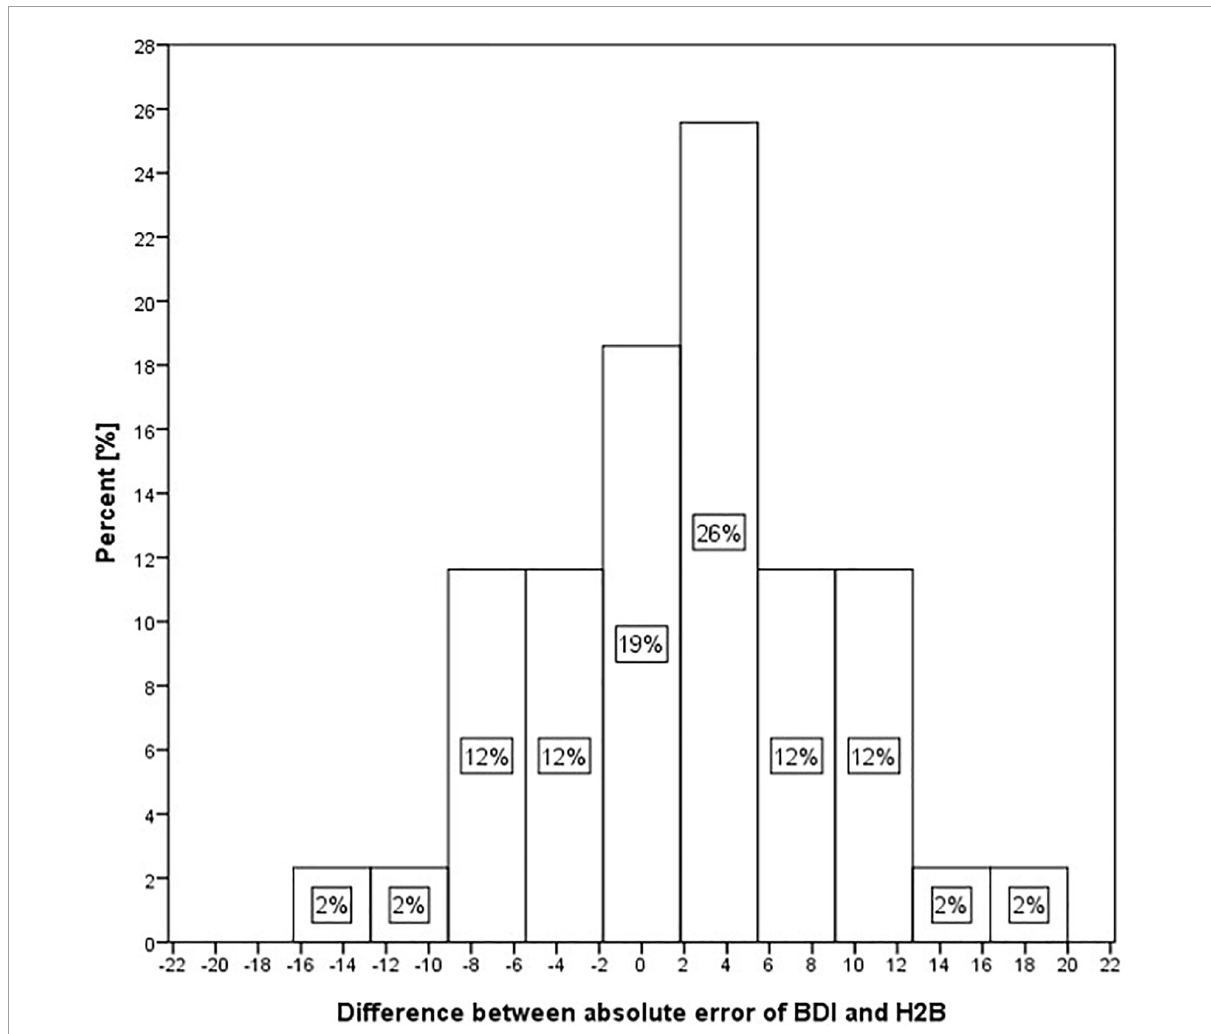
FIGURE3 Histogram of differences of absolute error in the case of BDI and H2B for Set